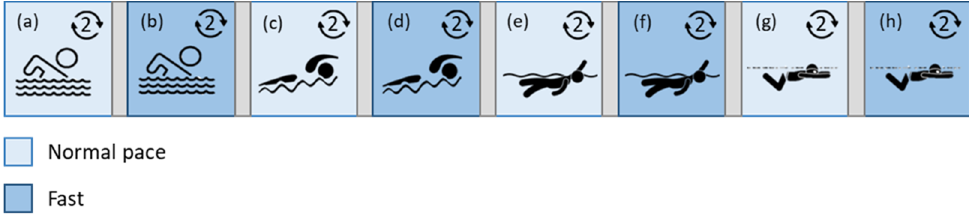
Figure 2. Laboratory test protocol (after initial recording at rest): exercises on treadmill, at two dif- ferent velocities, namely 4 km/h ( a – c ) and 6 km/h ( d – f ).